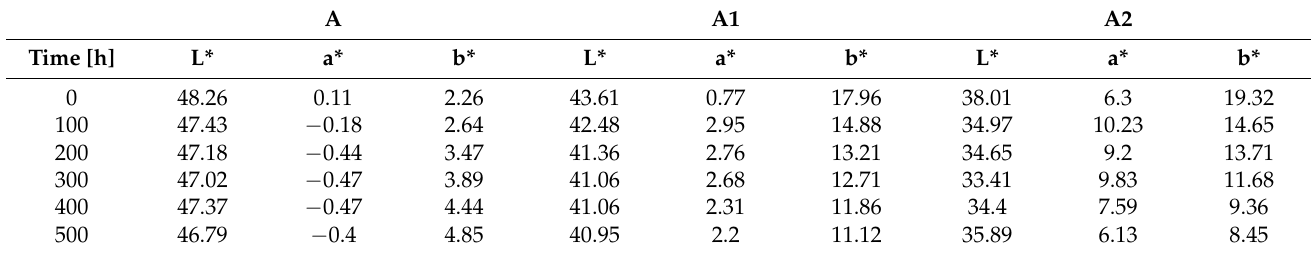
Figure 13. Evolution of the appearance of the coatings during the exposure to UV-B radiation. However, this phenomenon is due to the variation of the values of the coordinates a* and b*, as shown in the Table 3, rather than linked to a decrease in the brightness (L*) of the coating. Table 3. Evolution of the colorimetric coordinates of the samples during the exposure to UV-B ra- diation.